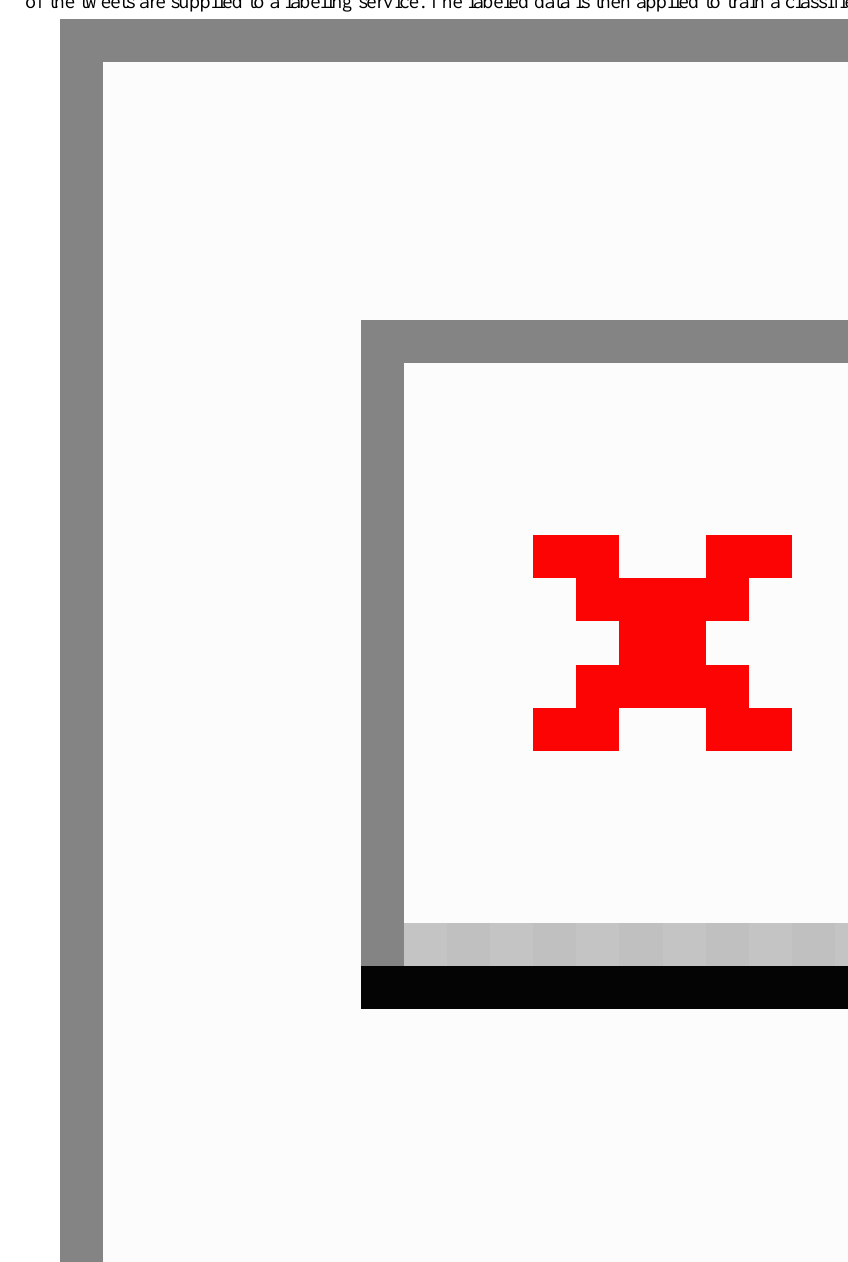
Figure 1. Framework for personal health mention detection over Twitter. First, tweets are filtered into bins according to health issue topic. A